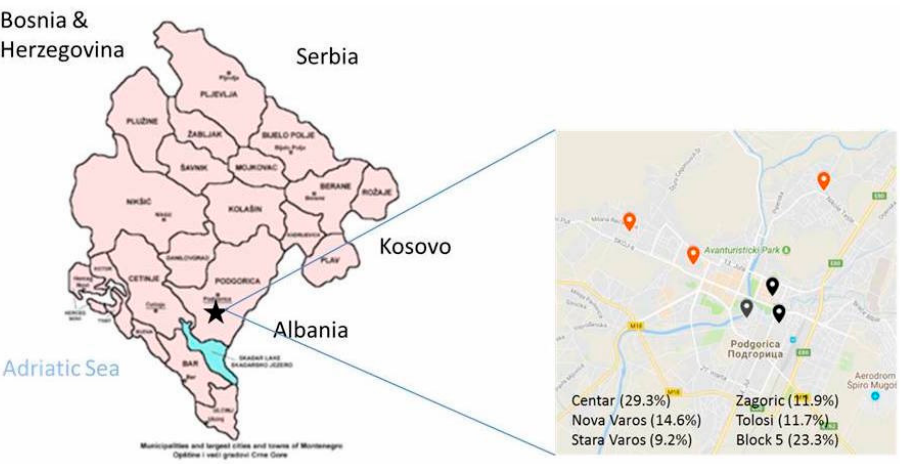
Figure 1. Geographical sampling from Podgorica.